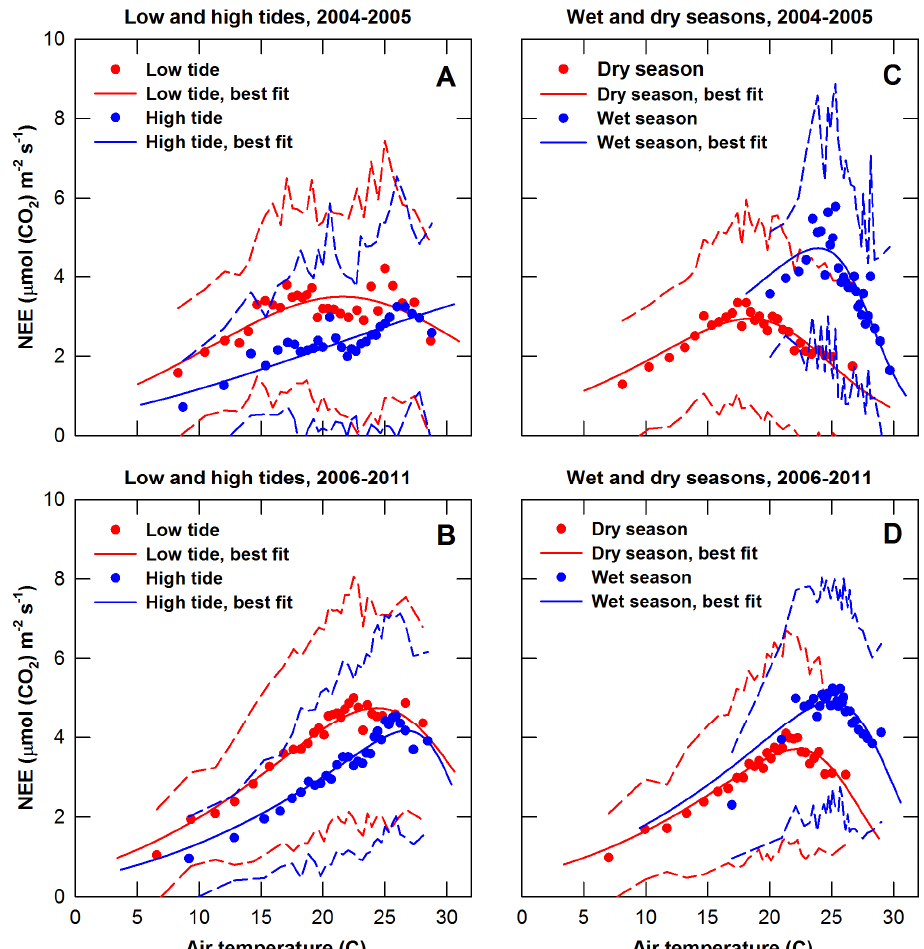
Fig. 2. Nighttime net ecosystem exchange (NEE (µmol(CO 2 )m − 2 s − 1 )) versus air temperature at 27m are partitioned by low- and high-tide periods in 2004–2005 (A) and 2006–2011 (B) , and by dry and wet season months in 2004–2005 (C) and 2006–2011 (D) . Each subset of the data was divided into 30 bins and the average (circles) and ± 1 standard deviation (dashed lines) were computed for each bin. Best-fit lines (Eq. 2) of the half-hourly NEE versus air temperature are included. During low-tide periods, NEE is equivalent to R E .